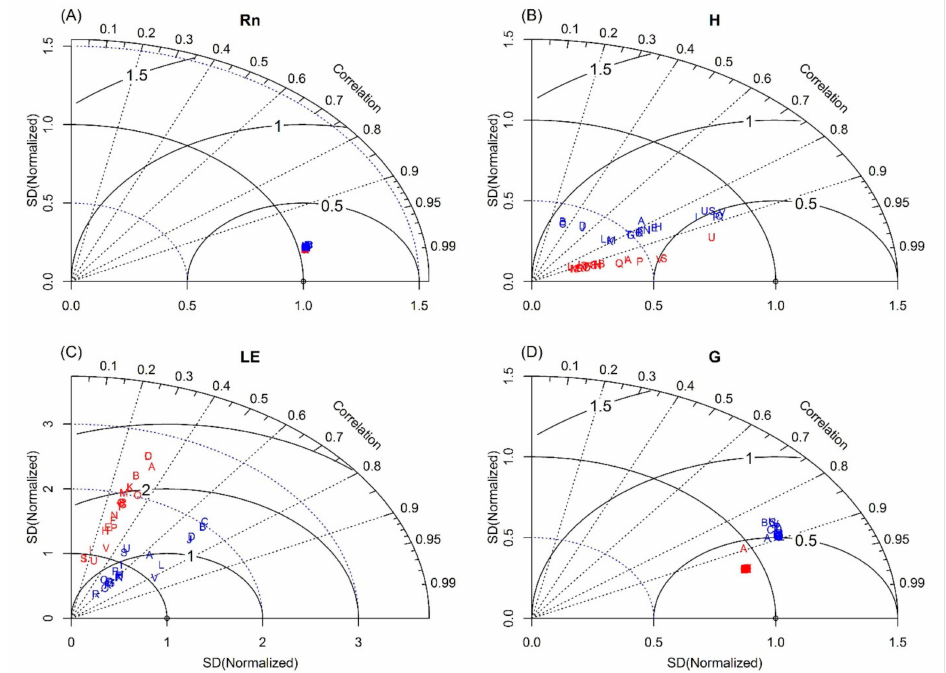
Figure 1. Taylor diagram of energy fluxes simulations against eddy covariance observations. Uppercase letters represent the different simulations in the wet season (blue letters) and dry season (red letters) of 2014. The open circle located at normalized standard deviation = 1.0 and RMSE = 0 indicates the eddy covariance observations. Standard deviation was normalized using hourly data of energy fluxes simulations and eddy covariance observations. Net radiation (Rn; ( A )), sensible heat flux (H; ( B )), latent heat flux (LE; ( C )) and soil heat flux (G, ( D )).